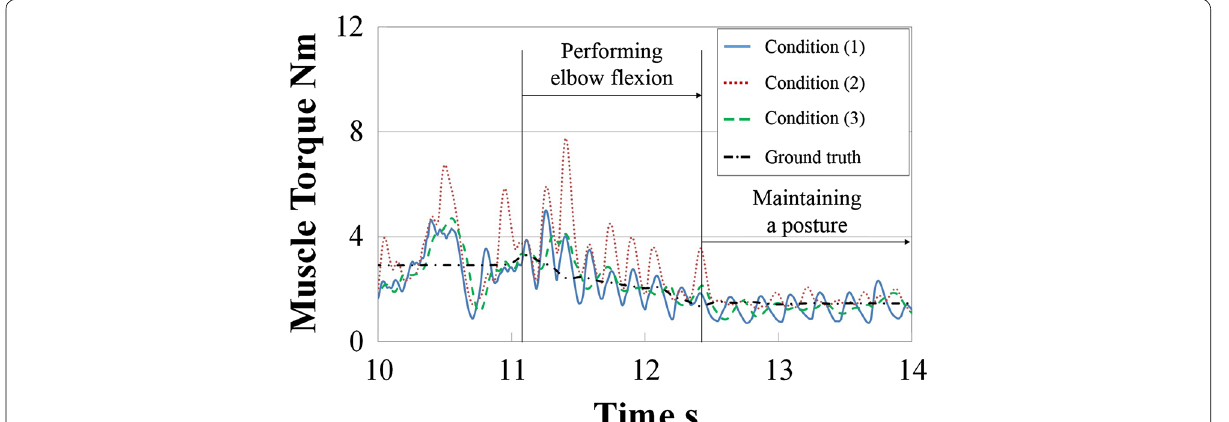
Fig. 12 Comparison between the estimated data and the ground truth